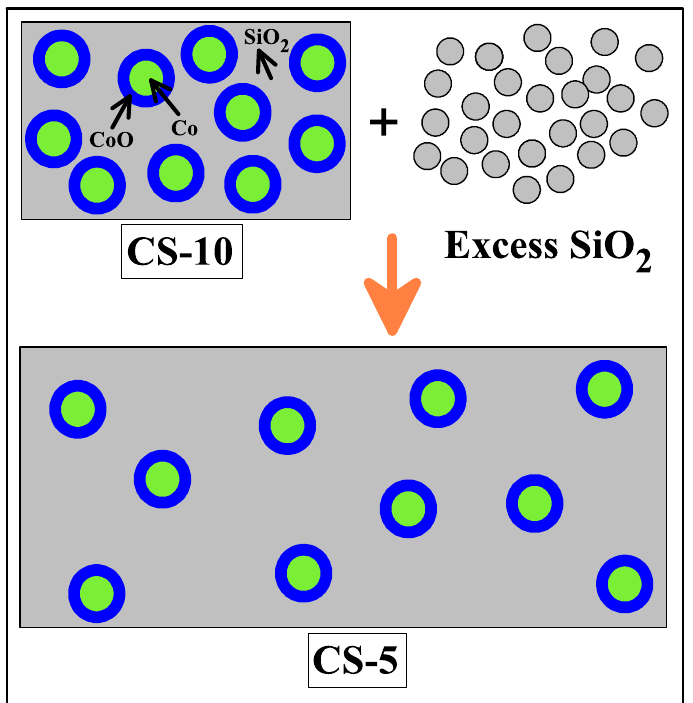
Figure 1. Schematic diagram representing change in volume fraction of Co/CoO nanoparticles from 10% to 5% by introducing excess silica matrix in the